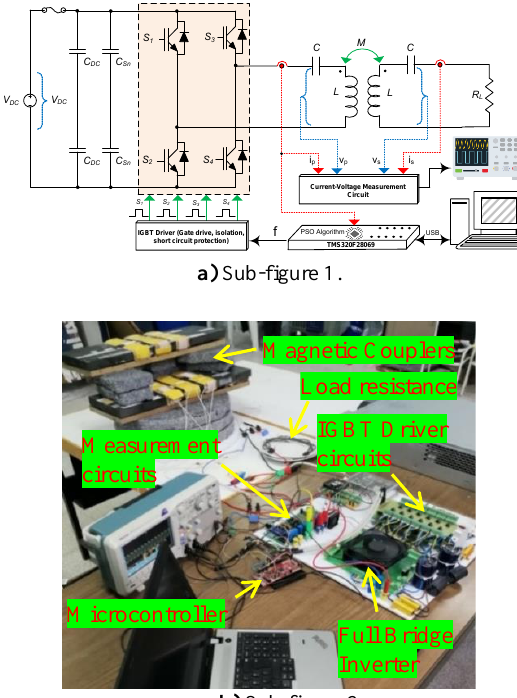
Figure 5. Block diagram (a) and photo of experimental